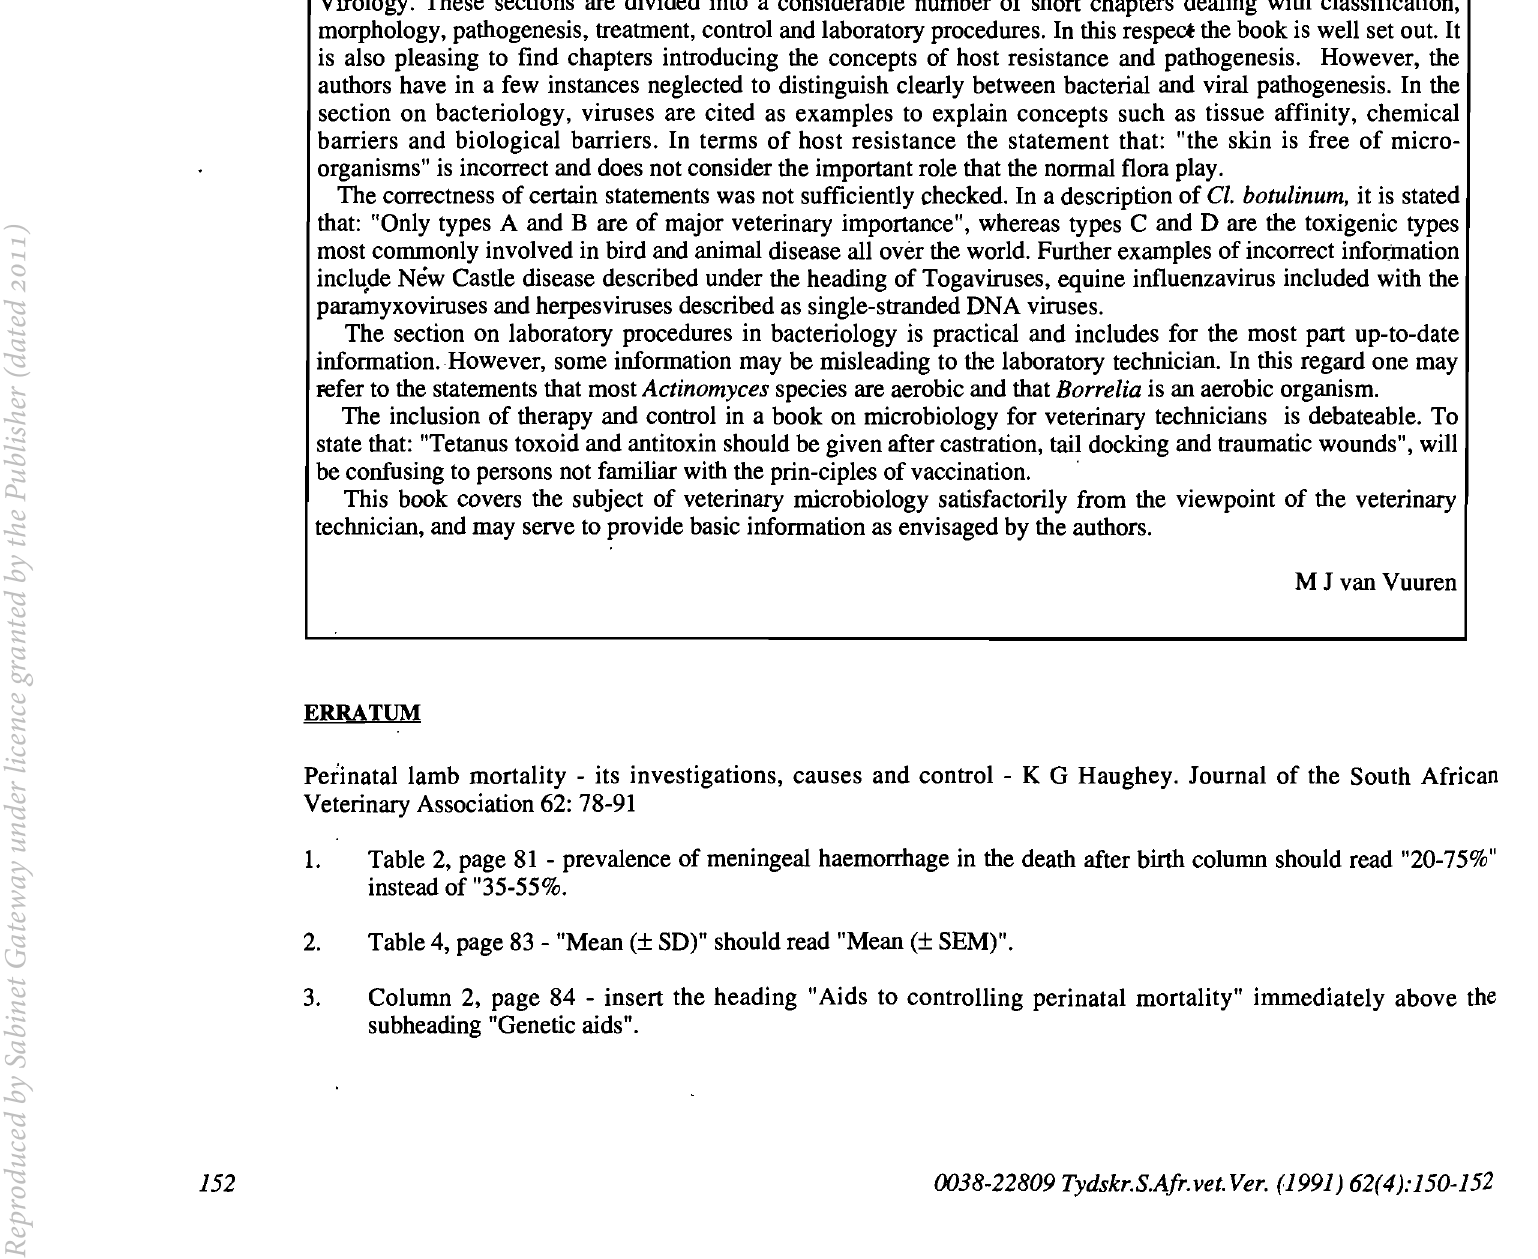
Table 2, page 81 - prevalence of meningeal haemorrhage in the death after birth column should read "20-75%" instead of "35-55%. Table 4, page 83 - "Mean (± SD)" should read "Mean (± SEM) " . Column 2, page 84 - insert the heading "Aids to controlling perinatal mortality" immediately above the subheading "Genetic